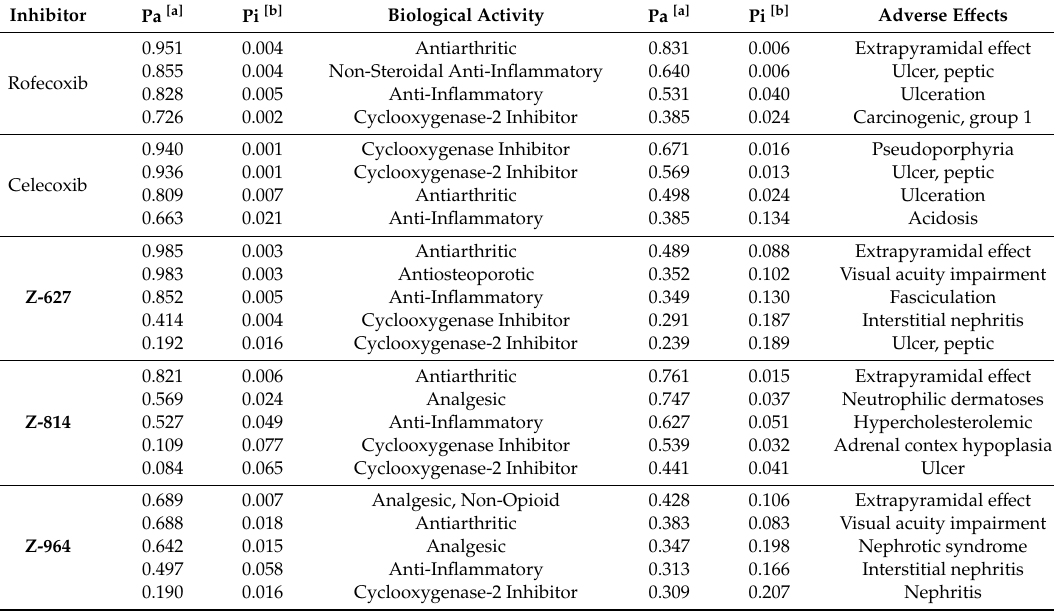
Table 10. Prediction of biological activity of selected